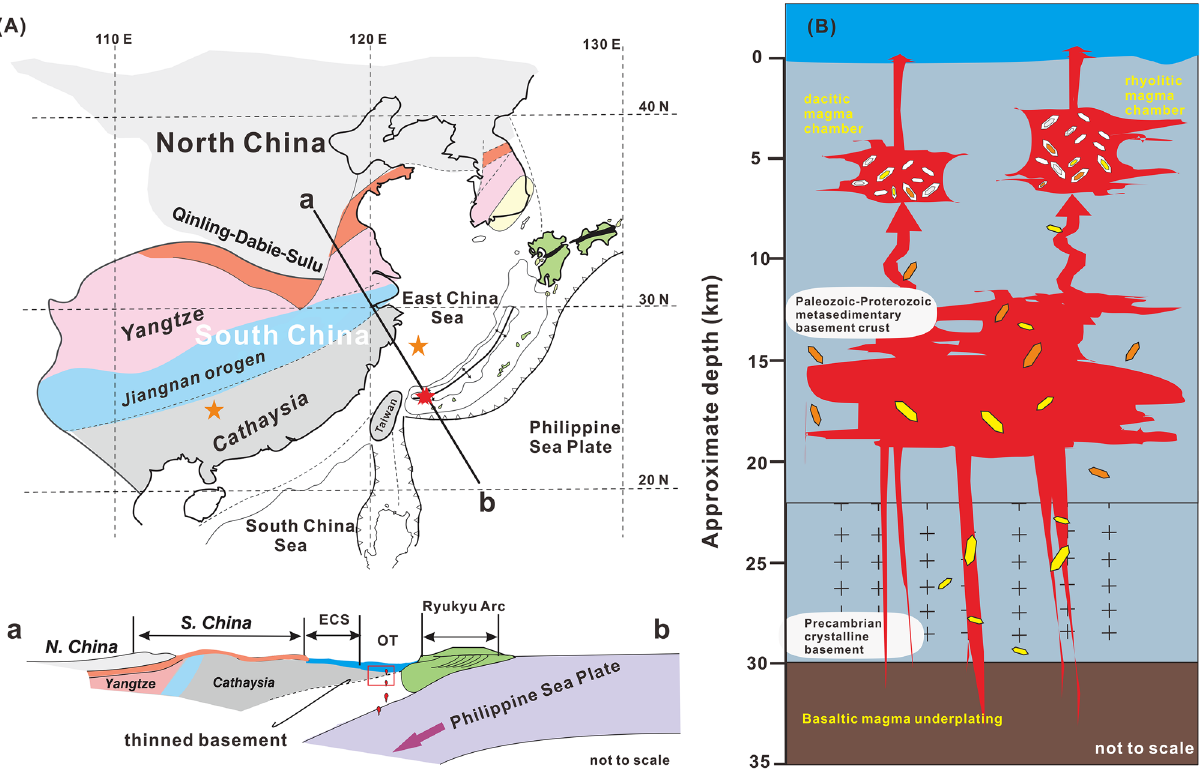
Figure 4. ( a ) The overall framework of the adjacent, major continental blocks and schematic profile across the OT and the China Block; modified from Isozaki 45 . The five-pointed stars show the sampling locations for this study, Li et al. 31 and Yuan et al. 30 . ( b ) The mantle-derived magma suffered crust assimilation, and xenocrystic zircons in the crust were carried by ascending magma to shallow magma chambers. The figure was generated using the coreldraw x7 software) https:// www. corel draw. com/ en/ pages/ corel draw-